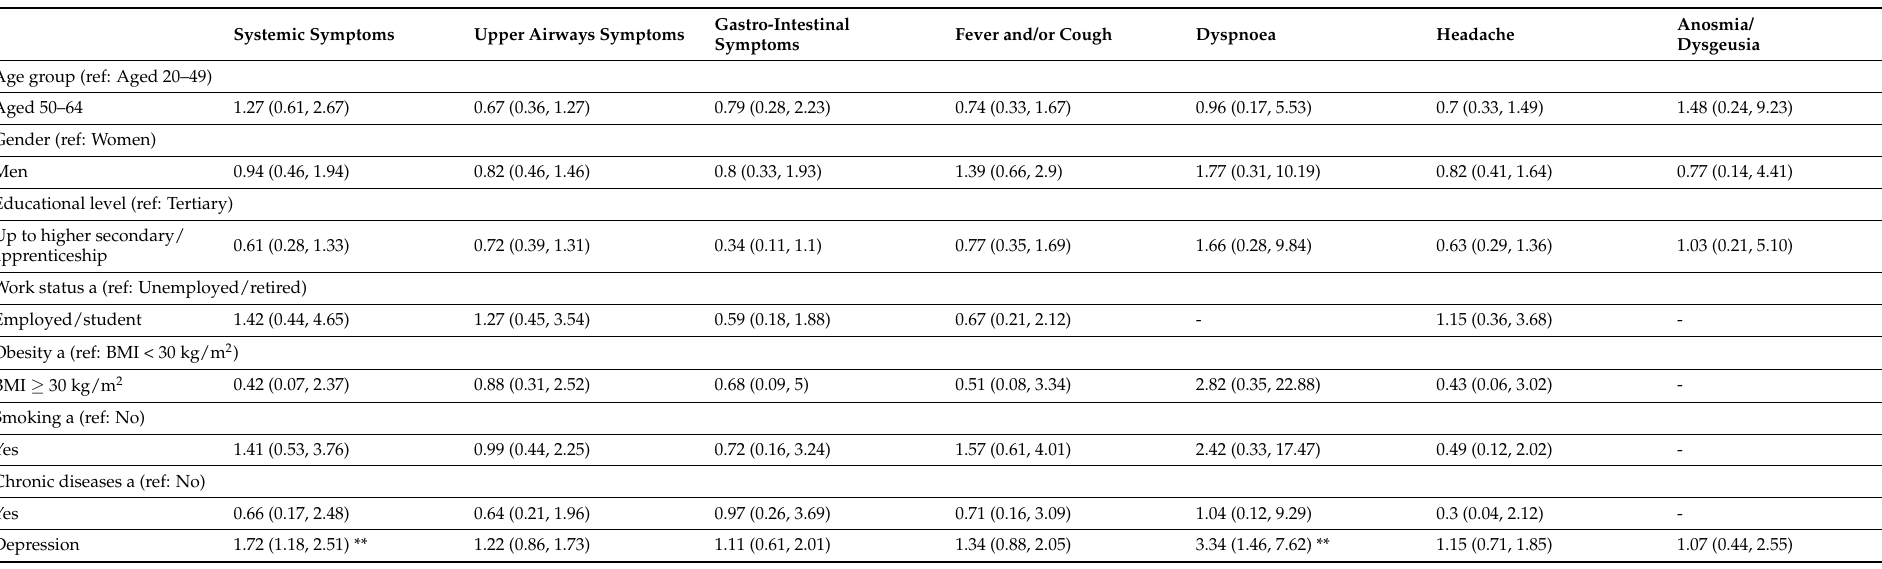
Table A8. Prevalence ratios (95% confidence intervals) from Poisson regressions estimating likelihoods of reporting COVID-19 symptoms at follow-up (January– February 2021), Geneva (N = 365).